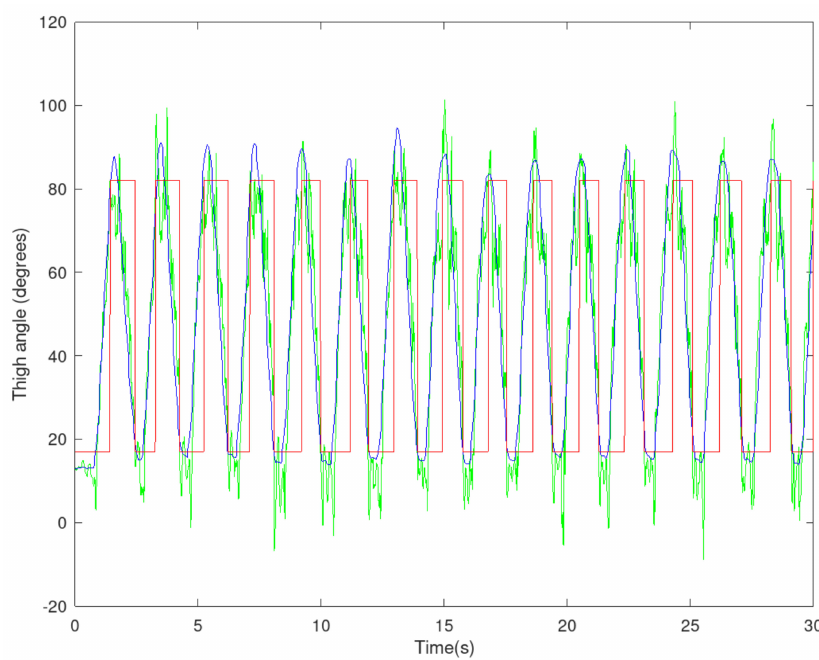
Figure 5. Graphical representation of the outcomes of a 30-s CST. The blue line represents the evolution of the thigh angle over time, computed from the estimation of the gravity components (it is not computed by the device). The green line represents the estimation of the thigh angle used in the device; it is directly computed from raw readings from the accelerometer. The red line represents the output of applying hysteresis thresholding to the green